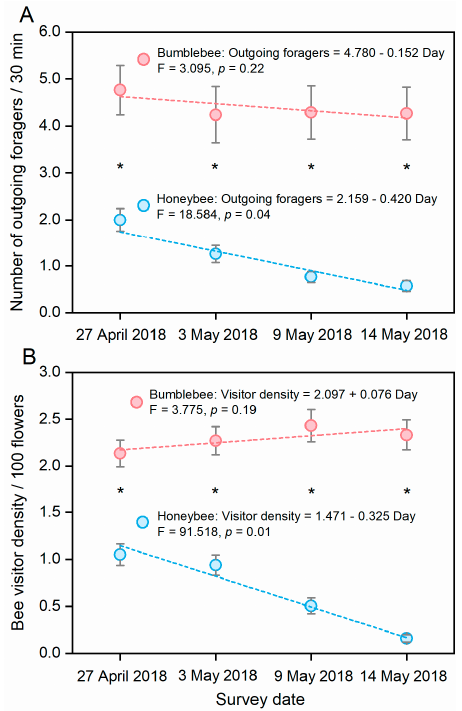
Figure 2. Daily pattern of ( A ) the number of outgoing foragers and ( B ) visitor density of Apis mellifera and Bombus lantschouensis in tomato greenhouses on different sampling dates. The behavior data were obtained in six greenhouses during the tomato flowering period, and a total of 168 records of the ‘number of outgoing foragers’ and a total of 324 records of ‘bee visitor density’ were obtained for both honeybees and bumblebees. Data are presented as the mean ± S.E. Asterisks indicate significant di ff erences ( p < 0.05) between A. mellifera and B. lantschouensis on each sampling day based on nonparametric Mann-Whitney U methods. Dashed lines depict linear regressions based on the mean value for each sampling date.